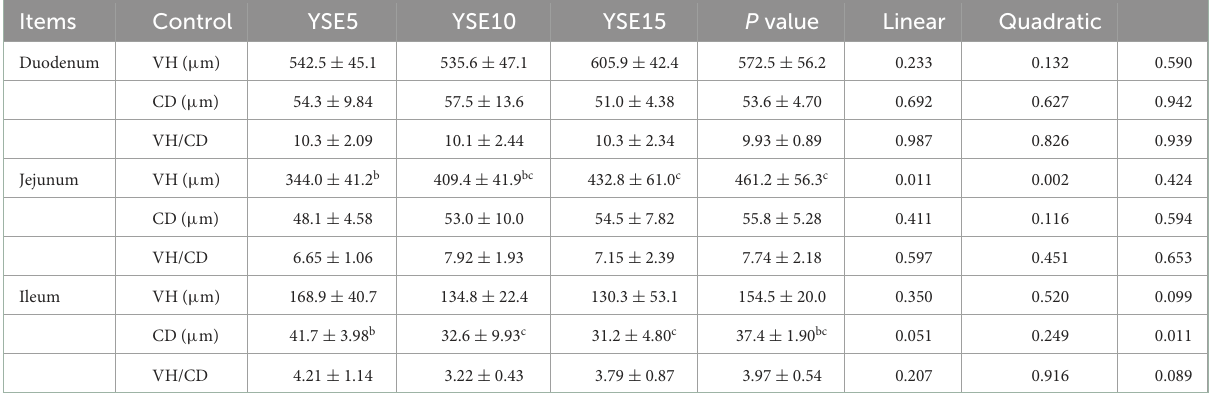
TABLE 6 Effect of supplemental different levels of YSE on the histomorphological parameters in the small intestine of young pigeons a . Items